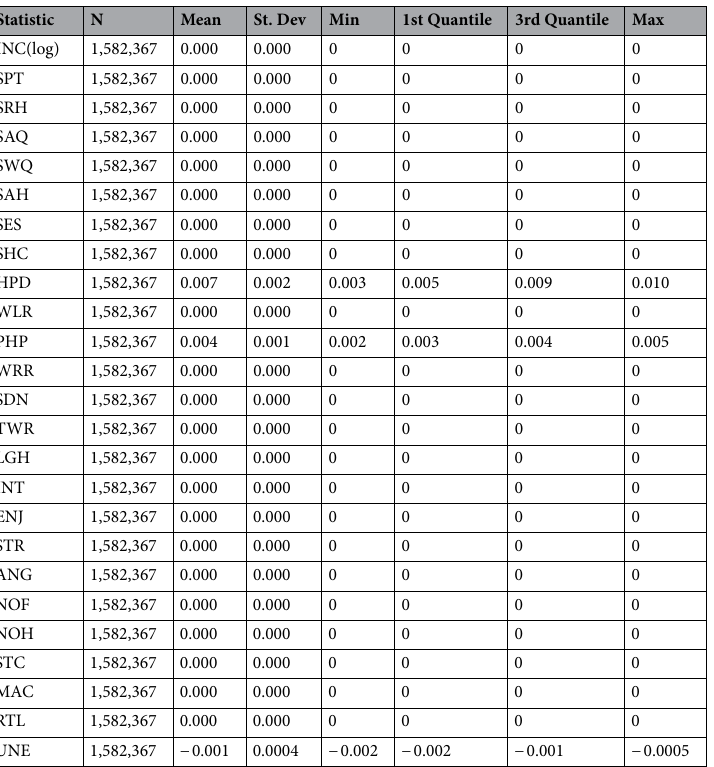
Table 3. The Cumulative Effects of Age on Each Variable Affecting